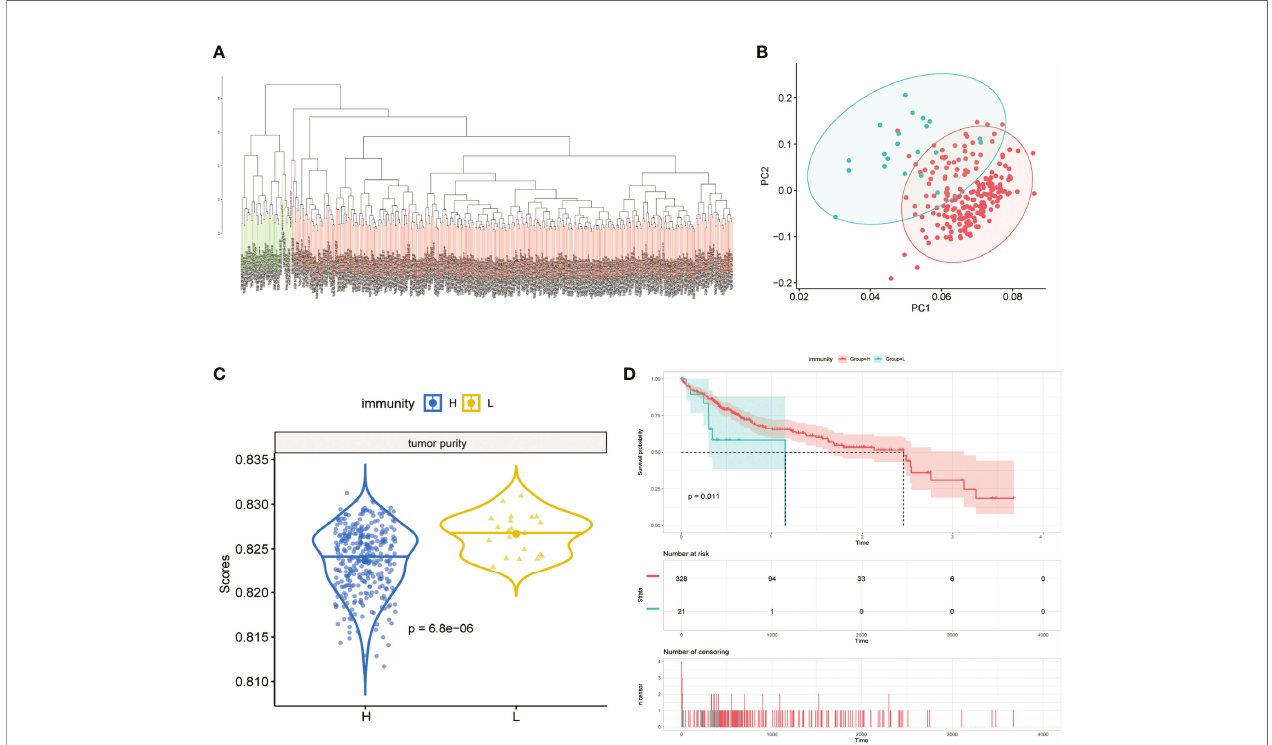
FIGURE 5 | Establishment of the MAPK-RAP1A with immunity in the TCGA database. (A, B) PCA based on MAPK-RAP1A gene signature between low-immunity group and high-immunity group. (C) Tumor purity in different immunity subgroups. (D) Kaplan – Meier curves of overall survival according to immunity groups in the training